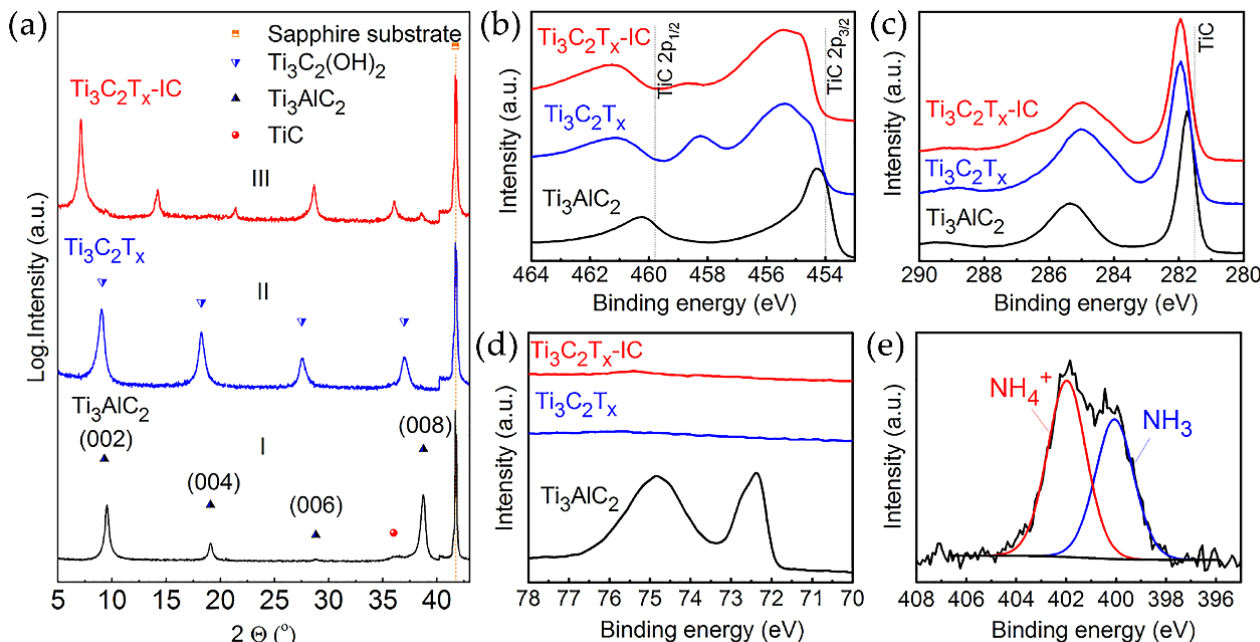
Figure 14. ( a ) X-ray spectra of (I) Ti 3 AlC 2 60 nm thick precursor film, Ti 3 C 2 T x MXene after etching in (II) 50% HF for 160 min and (III) 1 M NH 4 HF 2 for 660 min. The XPS spectra are shown in the right panels, where ( b ) Ti 2p, ( c ) C 1s, ( d ) Al 2p, and ( e ) N 1s (for MXene synthesized with NH 4 HF 2 ), where two components correspond to NH 4+1 and NH 3 [62].